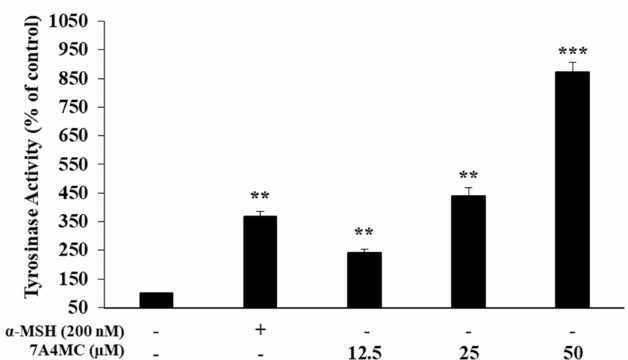
Figure 4. E ff ects of 7A4MC on tyrosinase (TYR) activity. B16F10 cells were treated with 7A4MC (12.5, 25, and 50 µ M) for 72 h. α -MSH (200 nM) was used as positive control. The data represent the mean ± SD of quadruple experiments. ** p < 0.01, *** p < 0.005.